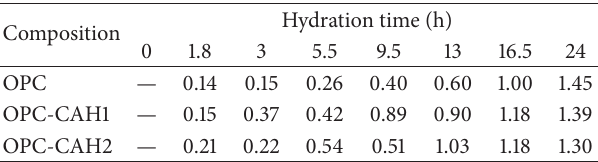
Table 4: The values of the main diffraction peak area of ettringite in OPC, OPC-CAH1, and OPC-CAH2